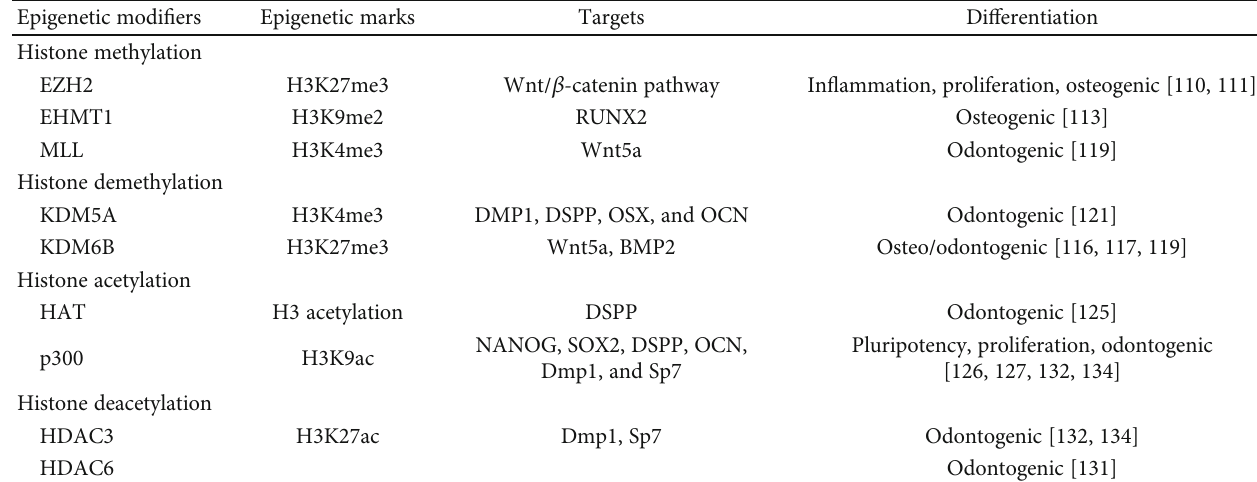
Table 2: Histone modi fi cations in